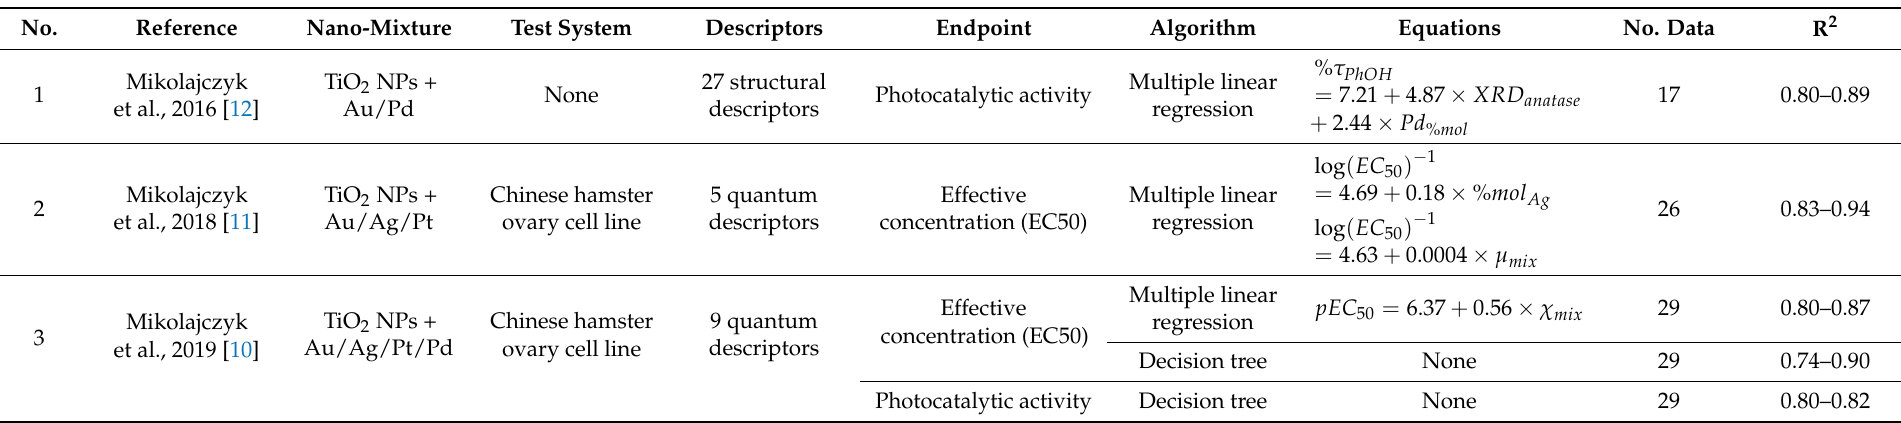
Table 1. List of previous QSAR models for